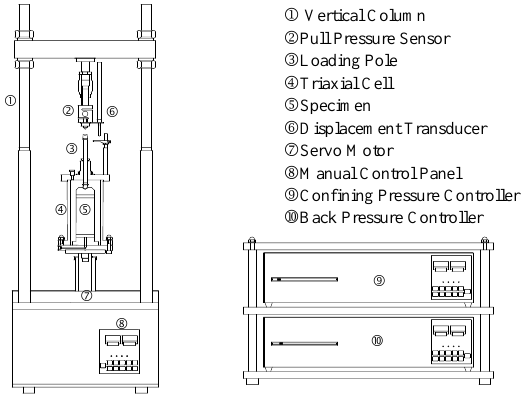
Figure 1. SLB-1 triaxial apparatus, Nanjing, China.